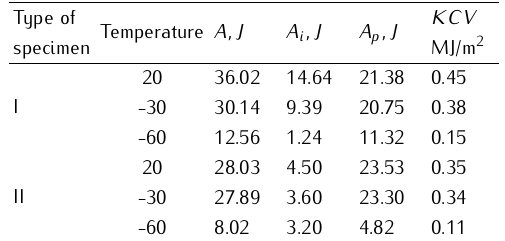
Table 1. Results of low temperature influence on impact